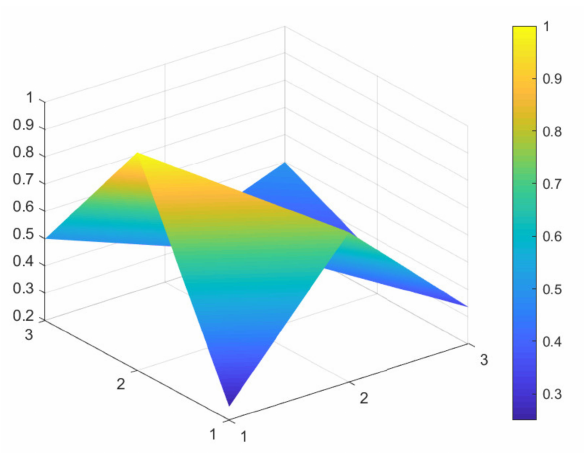
Figure 6. PMC-Surface chart of P6